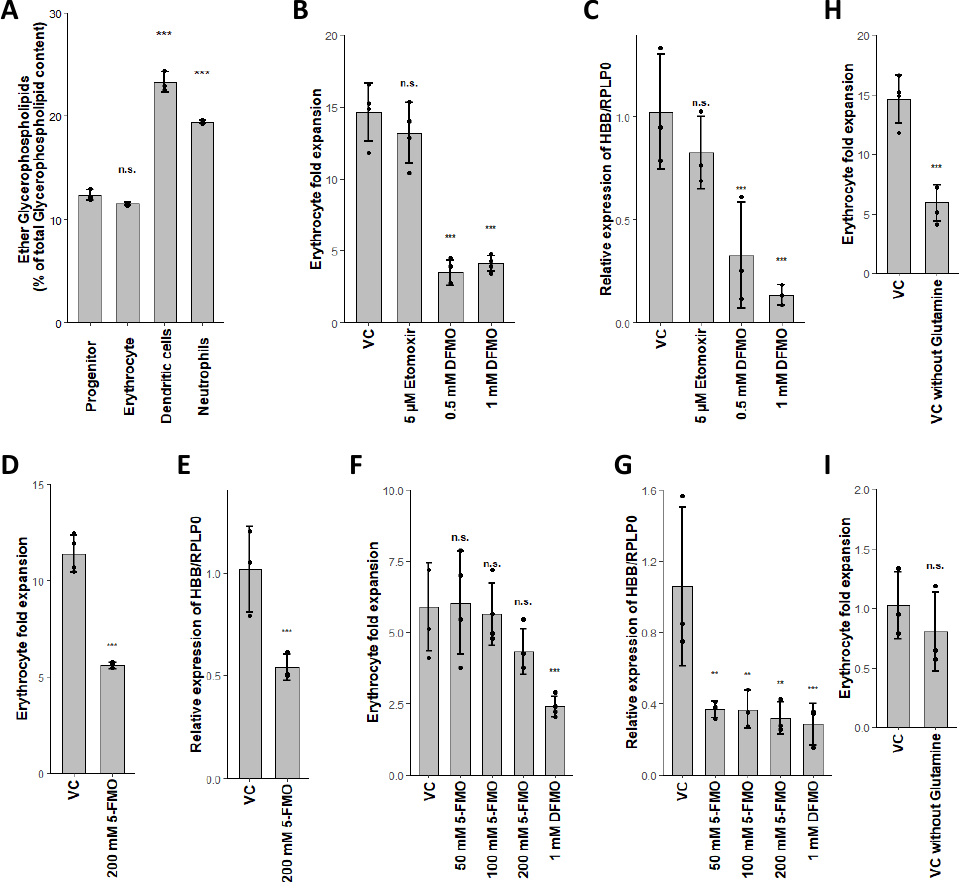
Figure 4. Polyamine synthesis and glutamine metabolism are both essential for erythropoiesis and interconnected via OAT . ( A ) Percentual content of ether lipids. ( B , C ) Effect of etomoxir or difluormethyl-ornithine (DFMO) in the presence of glutamine on erythroid expansion and relative HBB/RPLP0 expression. ( D , E ) Effect of 5-fluoromethylornithine (5-FMO) in the presence of glutamine on erythroid expansion and relative HBB/RPLP0 expression. ( F , G ) Effect of 5-FMO or DFMO in the absence of glutamine on erythroid expansion and relative HBB/RPLP0 expression. ( H , I ) Impact of glutamine on erythroid cell expansion and relative HBB/RPLP0 expression. Data are represented as mean ± SD ( n = 3 for ether lipid content and gene expression, n = 4 for cell expansion). Percentual content of lipids, expansion rates and relative gene expression was calculated as stated in the methods section. Significant changes were assessed by one-way ANOVA (n.s. not significant; ** p < 0.01; *** p <